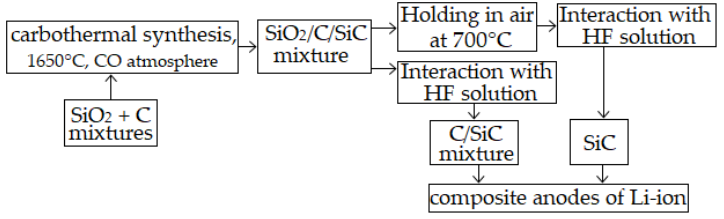
Figure 1. Process flow diagram for obtaining C/SiC mixtures for the manufacture of LIBs anodes.